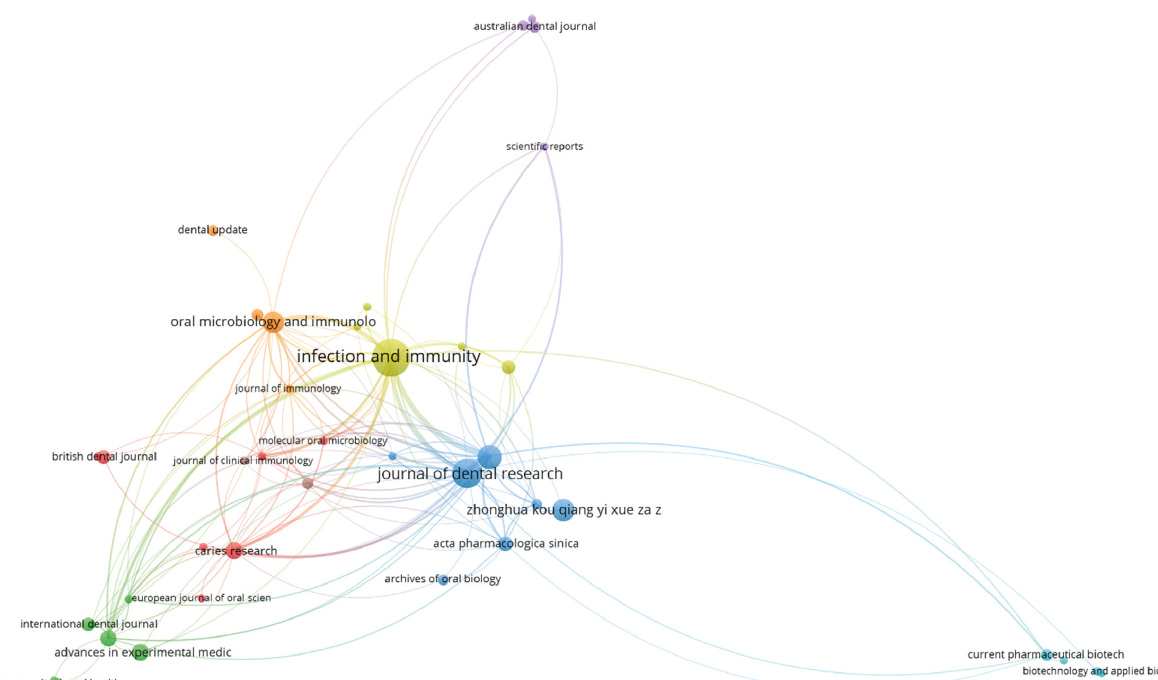
Figure 2: Citation by journal.